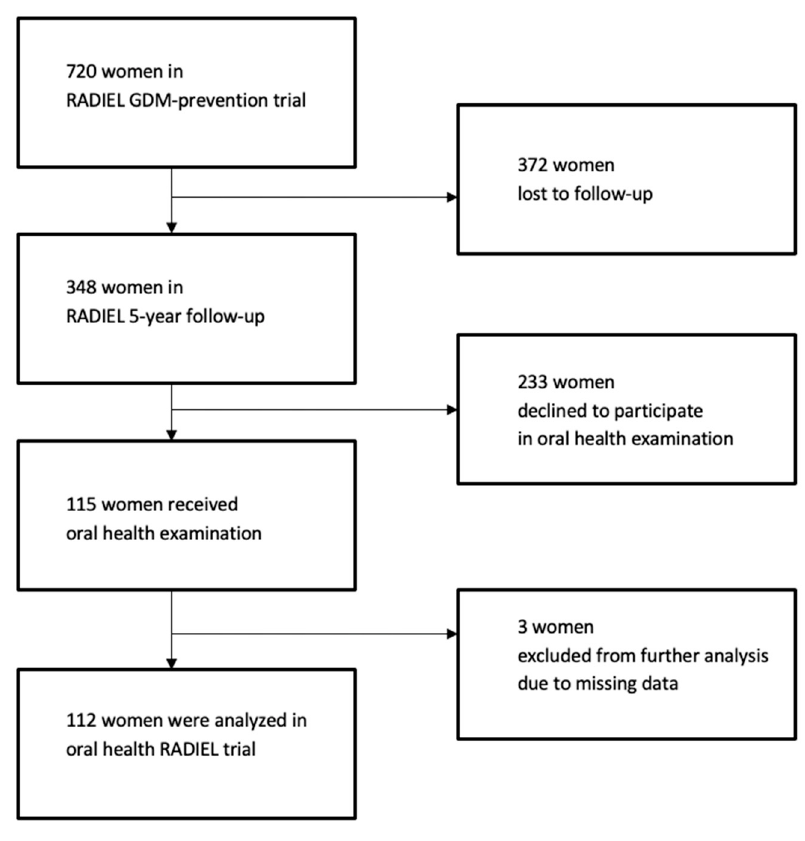
Figure 1. Study flow chart.